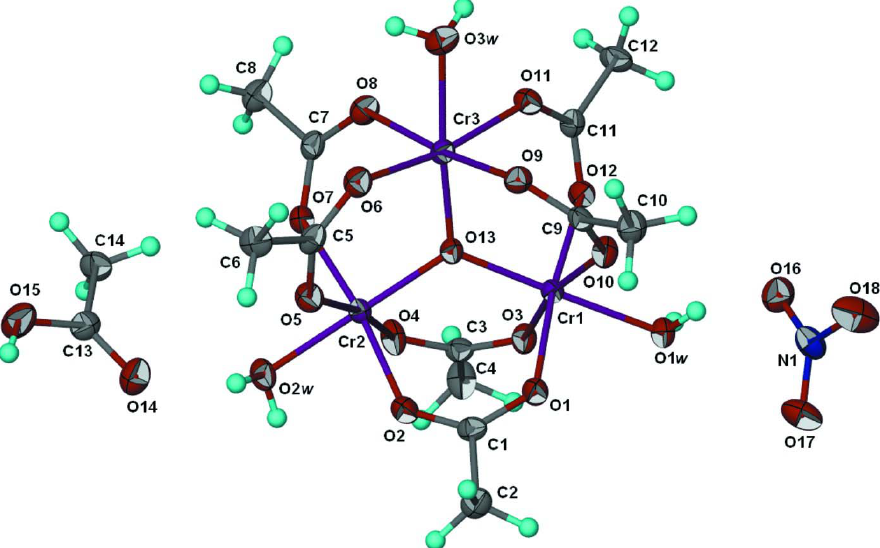
Thermal ellipsoid (Barbour, 2001) plot of [Cr atoms are drawn as spheres of arbitrary